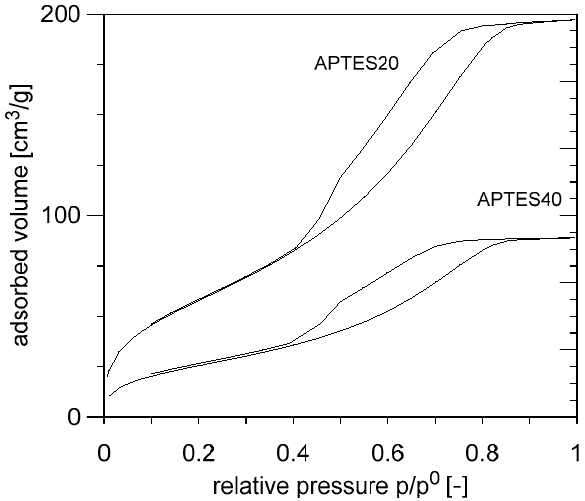
Figure 17. Nitrogen adsorption–desorption isotherms for the two amino-functionalized samples after ninth cycle of adsorption/regeneration.